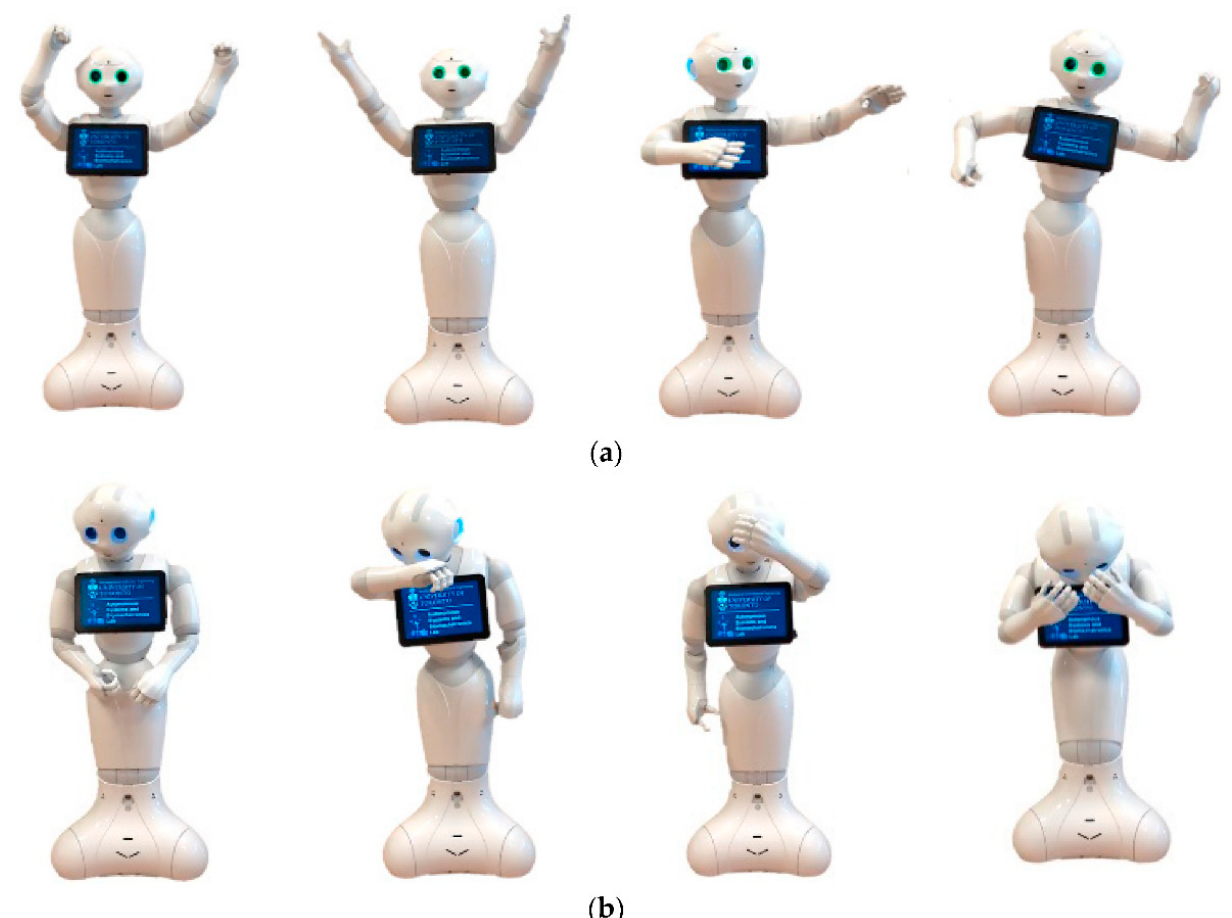
Figure 3. The Pepper robot displaying different emotions using nonverbal communication via its head, torso, and arm movements and changing eye colors: ( a ) positive valence and high arousal; and ( b ) negative valence and low arousal; courtesy of Shao et al. [116], open access article.